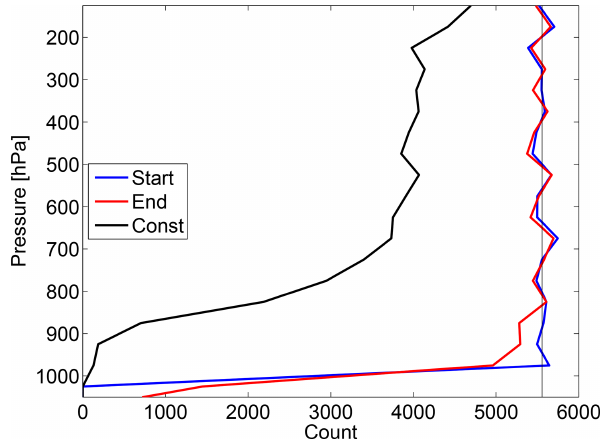
Figure 8. Conservation of vertical mass distribution after 20d for forward trajectories and using a constant convective area fraction profile. Number of trajectories in 50hPa bins at the start of the run (blue) and at the end of the run (red). The black line denotes the number of trajectories that did not move due to zero convective mass flux at their start